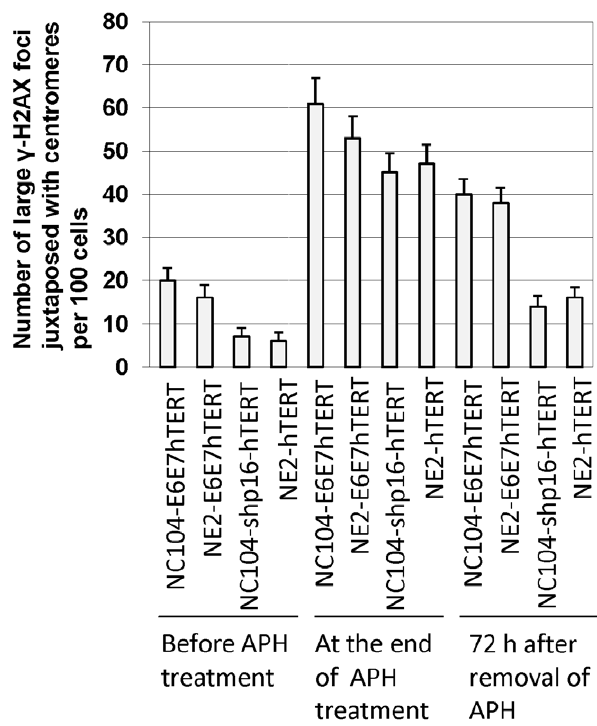
Figure 5. Number of large c -H2AX foci juxtaposed with centromeres per 100 cells. Two hundred cells were analyzed for each experimental condition. All cell lines were analyzed at PD 80. P , 0.05 for the differences between HPV 16-E6E7-hTERT-immortalized cell lines and hTERT-immortalized cell lines of the same cell origins without APH treatment, or 72 h after removal of APH.